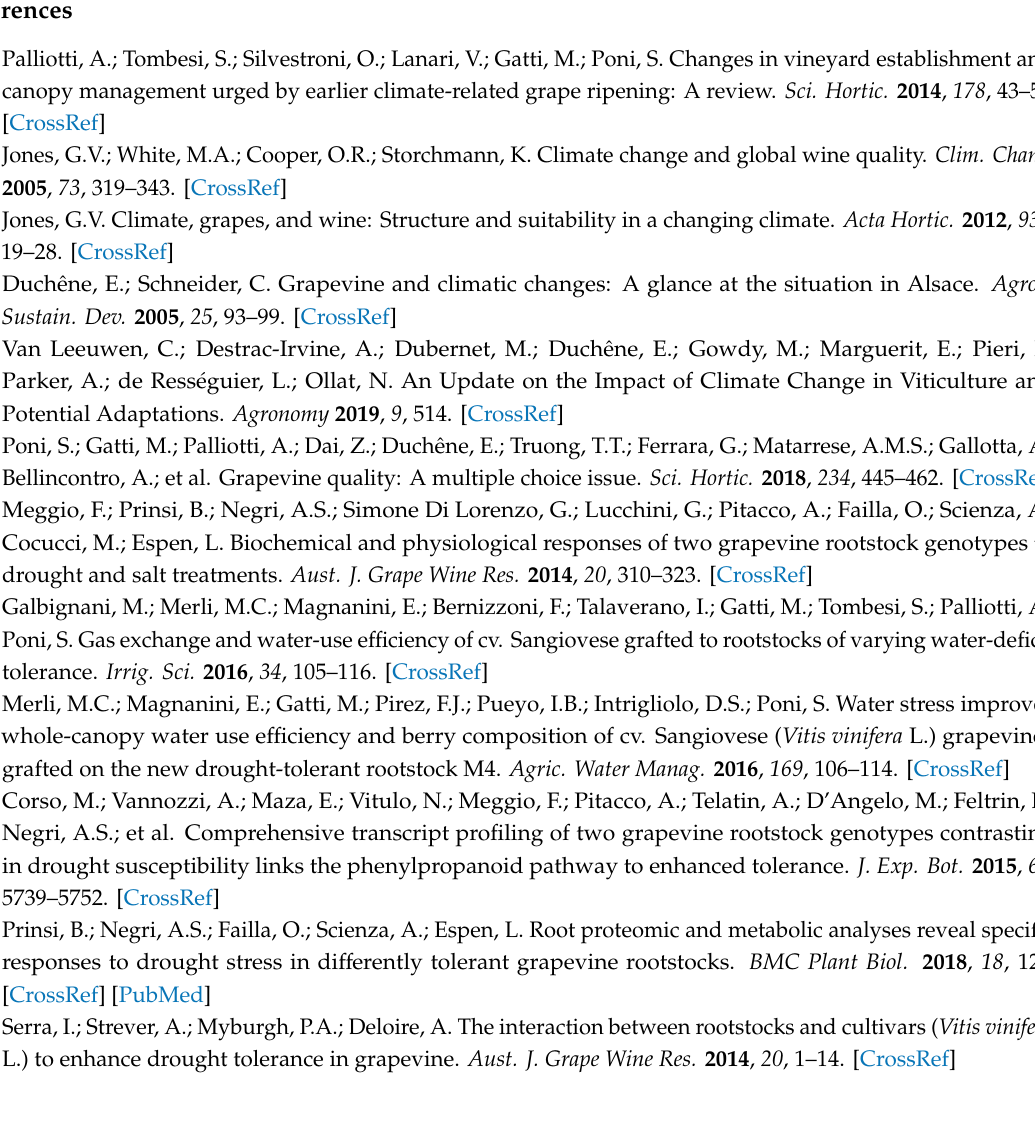
Supplementary Materials: The following are available online at http: // www.mdpi.com / 2073-4395 / 10 / 5 / 708 / s1. Figure S1: Hourly trends of air temperature (T), and relative humidity (RH) and daily trend of air vapor pressure deficit (VPD) and rainfall recorded at the experimental site over the trial period. The arrows indicate the first day of water stress imposition (WS) and the date of re-watering (RW). Figure S2: Daily trend for leaf stomatal conductance (g s ) of vines cv. Grechetto Gentile grafted to M4 and 1103 Paulsen. M4-WW = well-watered vines grafted to M4; 1103P-WW = well-watered vines grafted to 1103 Paulsen; M4-WS = water-stressed vines grafted to M4; 1103P-WS = water-stressed vines grafted to 1103 Paulsen; DOY = day of the year. Bars represent standard errors ( n = 5). Asterisk indicates dates within which significant di ff erences among treatments were found according to SNK test ( p < 0.05). Solid arrow indicates date of imposition of WS, dashed arrow indicates date of re-watering. Table S1: Leaf area from primary and lateral shoots of vines cv. Grechetto Gentile grafted to M4 and 1103 Paulsen. M4-WW = well-watered vines grafted to M4; 1103P-WW = well-watered vines grafted to 1103 Paulsen; M4-WS = water-stressed vines grafted to M4; 1103P-WS = water-stressed vines grafted to 1103 Paulsen; DOY = day of the